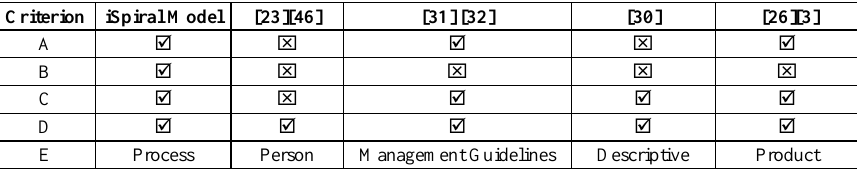
Table 3. iSpiral compared with related innovation